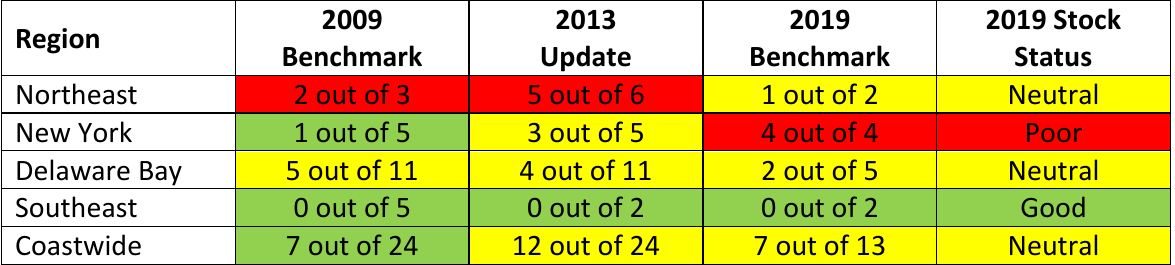
Table 1. Stock status determination for the coastwide and regional stocks based on the 1998 index-based reference points from ARIMA